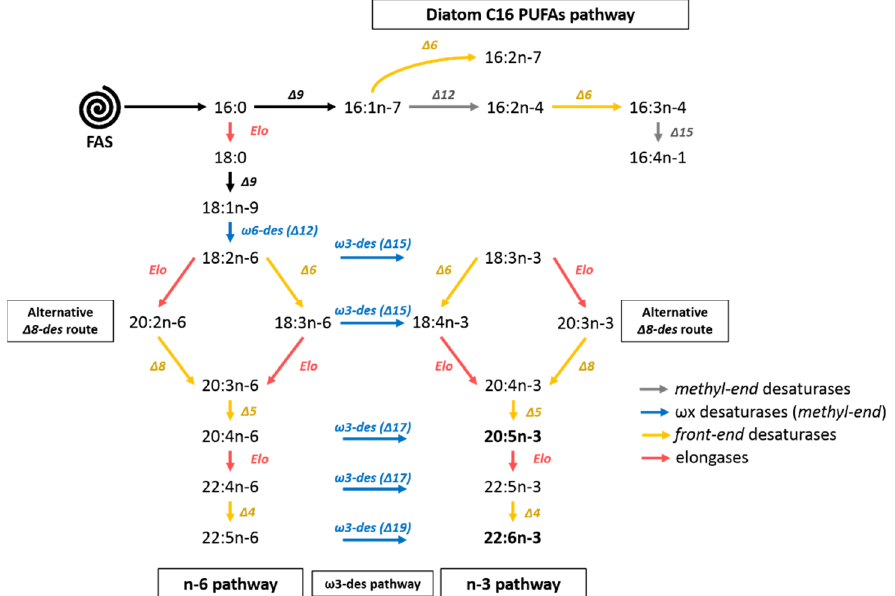
Figure 1. Fatty acids synthesis in diatoms. Desaturases are noted with “ ω ” and / or “ ∆ ” and refer to the location of carbon holding the newly formed double bond and its position within the methyl or front end of the acyl chain (2 types, methyl-end (grey or blue arrows) or front-end desaturases (yellow arrows)). Des: desaturase, Elo: elongase, FAS: fatty acid synthase.